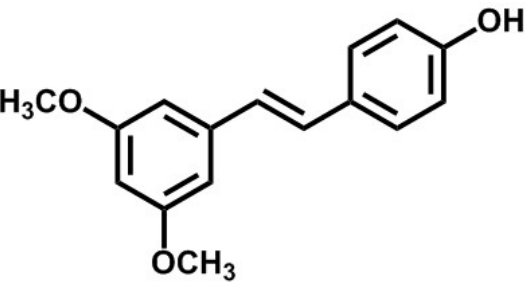
Figure 1. Chemical structure of pterostilbene.